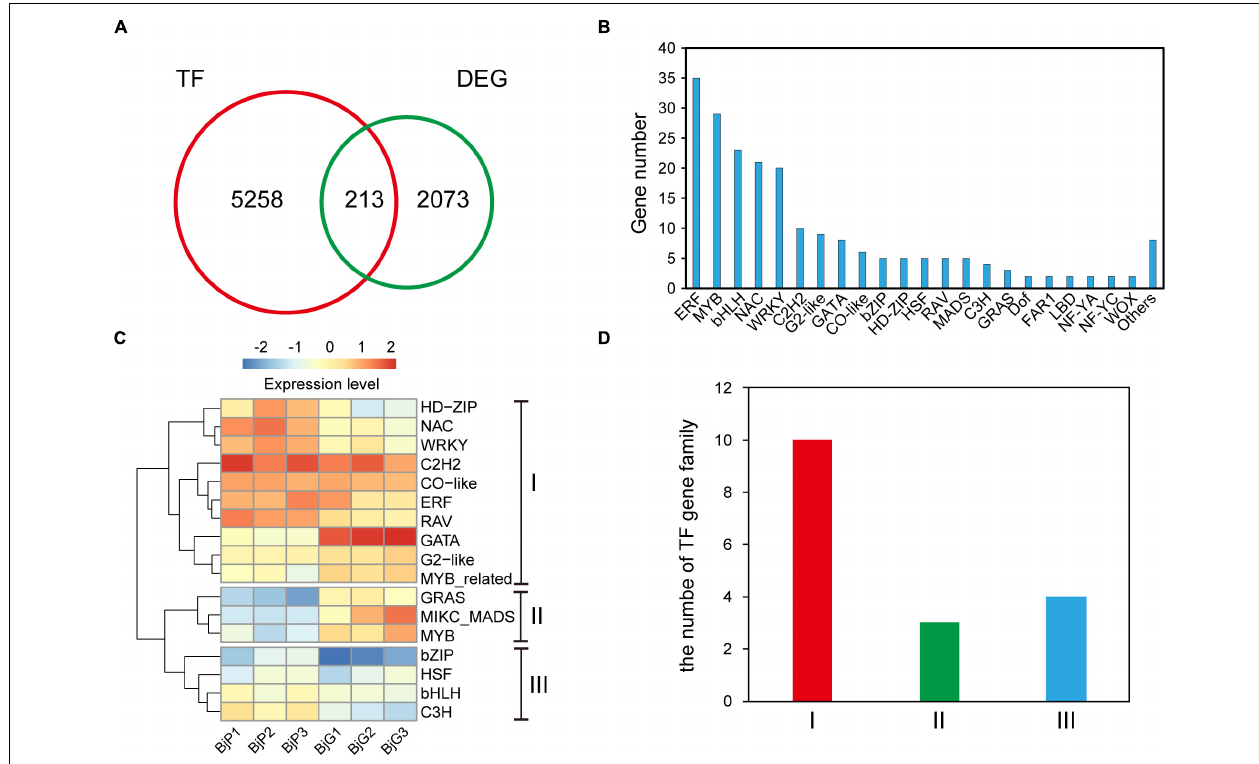
FIGURE 3 | Distinct expression patterns of transcription factors. (A) The number of different expressed transcription factors between ZiYi and LvYi. (B) Gene numbers of different type transcription factors among the DEGs between ZiYi and LvYi. (C) Heatmaps representing the distinct expression patterns of transcription factors between ZiYi and LvYi. BjP1, BjP2, and BjP3 representative three biological replication in ZiYi. BjG1, BjG2, and BjG3 representative three biological replication in LvYi. (D) Comparison of the clusters of TF